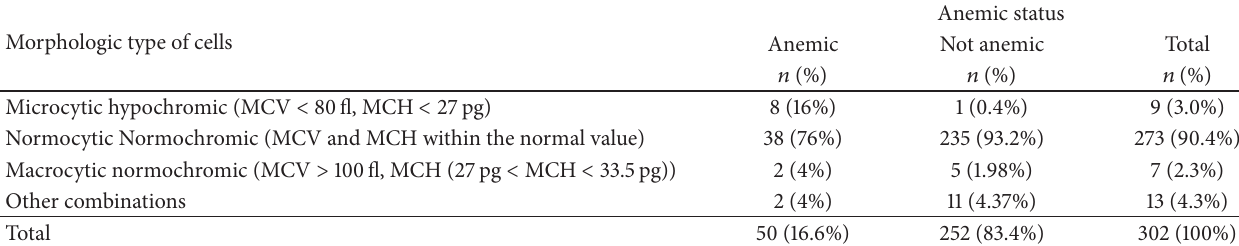
Table 4: Distribution of morphologic type anemia among study